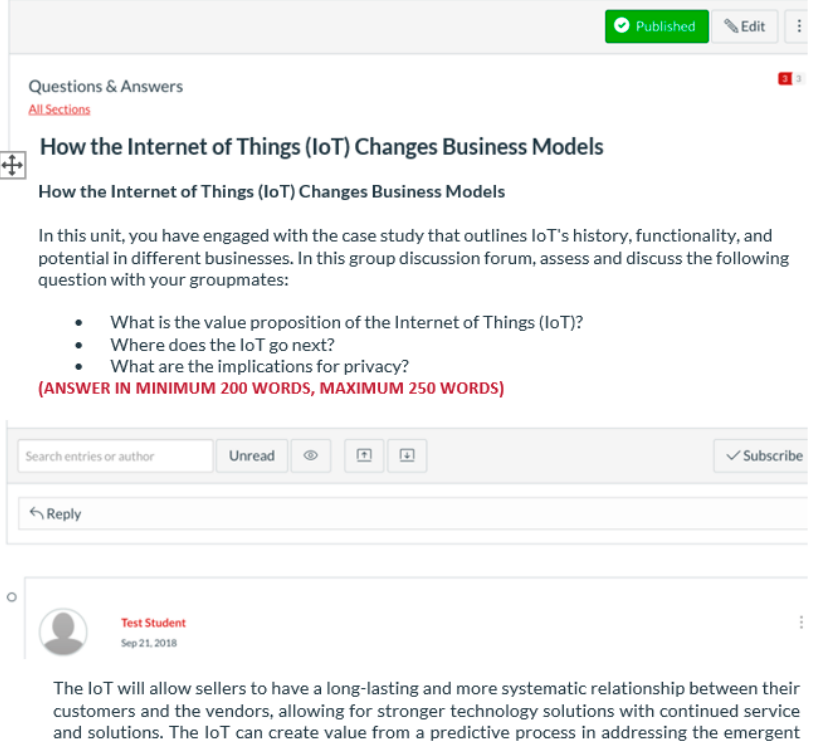
Figure 1. An illustration of the online discussion on Learning Management System.